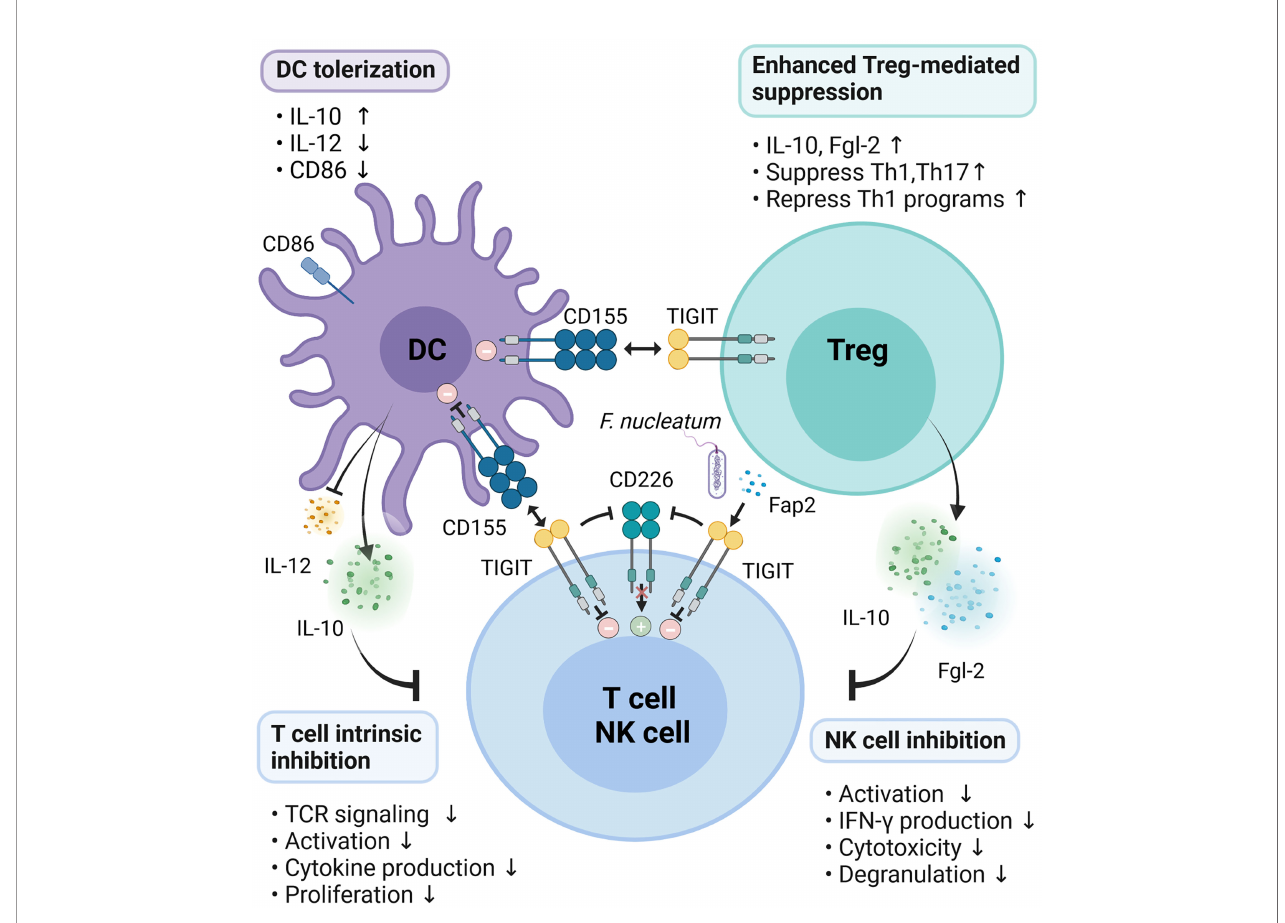
FIGURE 2 | Mechanisms of TIGIT inhibition on immune responses. TIGIT expression on T/NK cells interacts with CD155 expressed on DCs or Fap2 protein form F. nucleatum to elicit direct inhibitory signals in T/NK cells. Engagement of CD155 on DCs by TIGIT induces immunosuppressive DCs by triggering IL-10 production while decreasing IL-12 secretion and CD86 expression, which indirectly inhibit T cells function. Activation of TIGIT enhances Treg-mediated suppression via secretion of IL-10 and Fgl2, suppression of Th1/Th17, and inhibition of Th1 programs. In addition, TIGIT disrupts CD226 homodimerization to impede CD226-mediated stimulatory